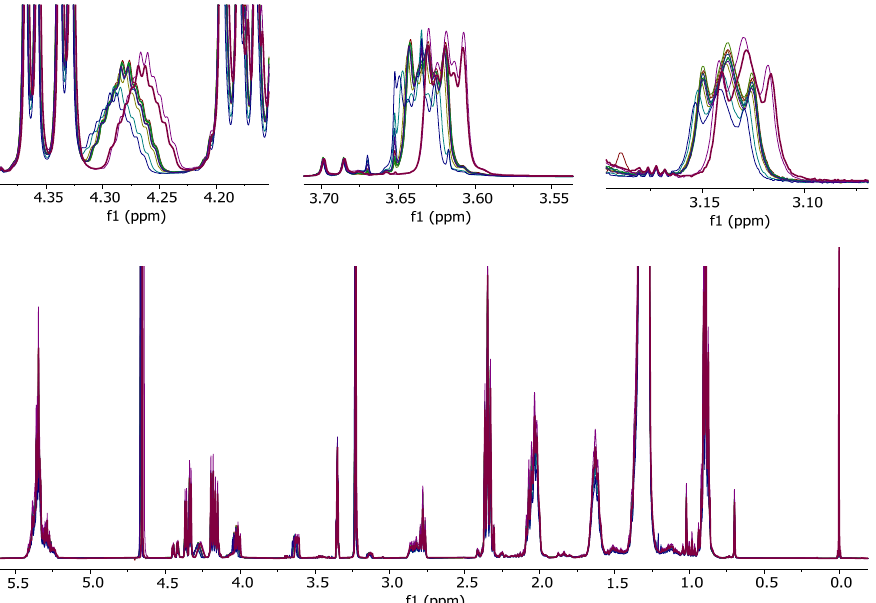
Figure 2. Superposition of thirteen 1 H-NMR spectra of fat extracts of egg yolk samples from different preparation batches. Solvent was untreated (D 1 )chloroform and (D 4 )methanol (3/2, v / v ). 1 H-NMR spectra, 400 MHz, 290 K, referenced to δ TMS = 0.00 ppm. The zoomed sections (on top) show NMR resonances with inconsistent chemical shifts, presumably due to untreated chloroform. As described by Ackermann et al. [9], the multiplets at 4.26 ppm and at 3.62 ppm belong to phosphatidylcholine; the multiplet at 3.13 ppm belongs to phosphatidylethanolamine.